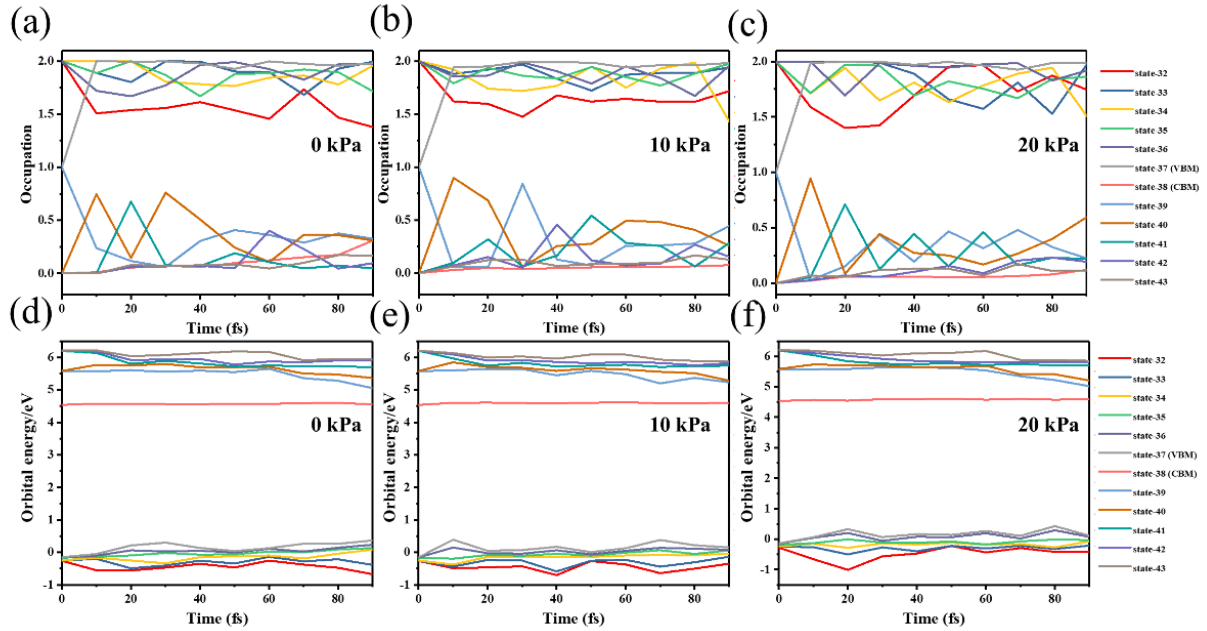
Figure 4. The hot carrier cooling process in perovskite CsPbI 3 under different pressure. ( a ), ( b ) and ( c ) represent the change in occupation state under pressure 0 kPa, 10 kPa and 20 kPa, respectively. ( d ), ( e ) and ( f ) represent the change in orbital energy under pressure 0 kPa, 10 kPa and 20 kPa, respectively.